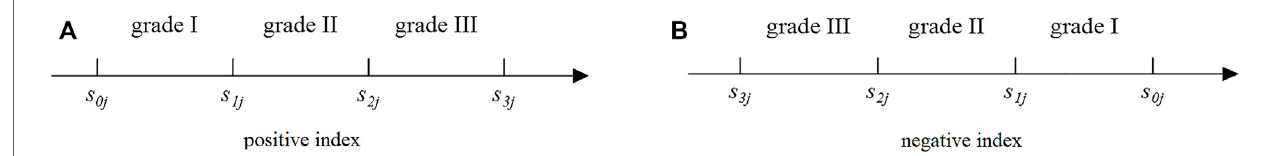
FIGURE 2 | Evaluation grade division. (A) positive index (B) negative